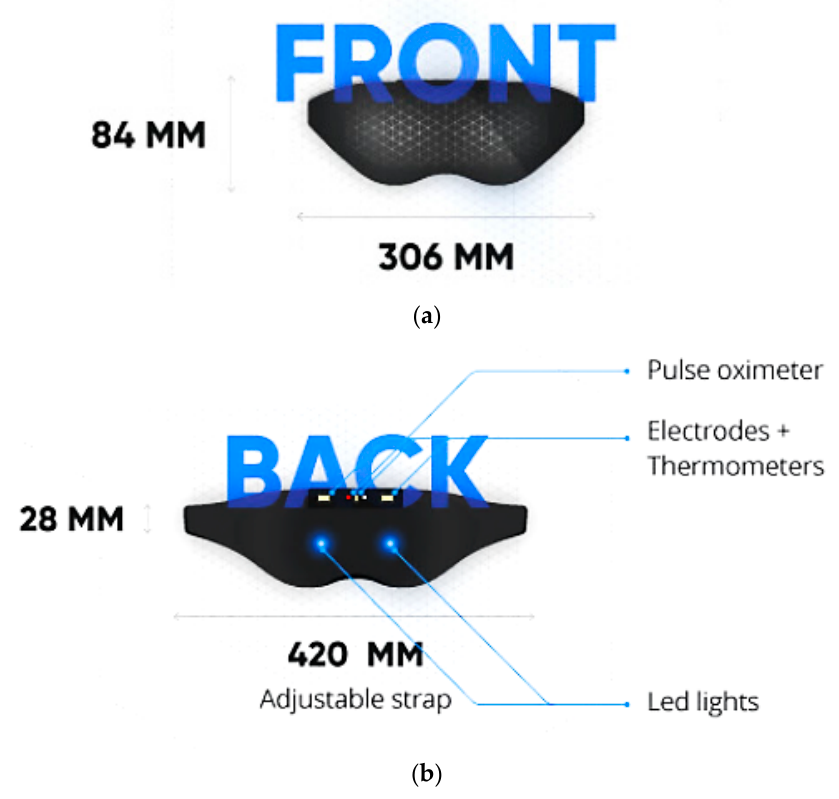
Figure 4. Front ( a ) and rear ( b ) views of Neuroon Open mask [59].